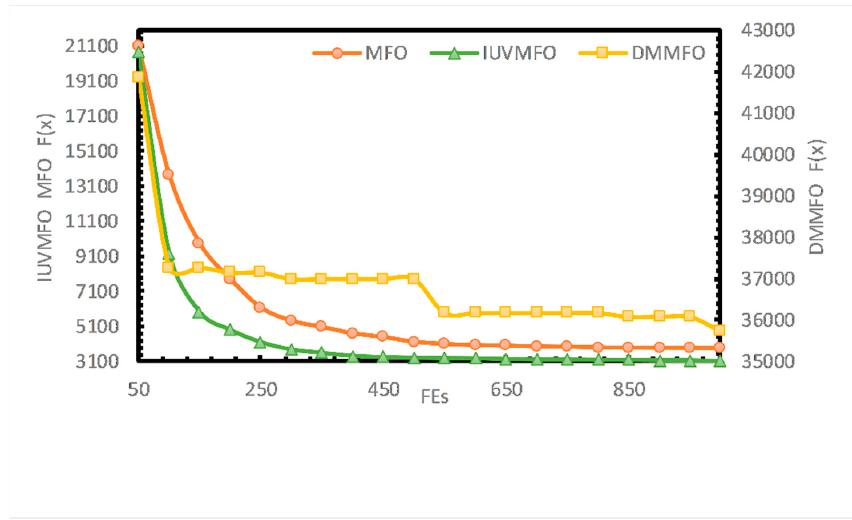
Figure 10. The result curve of F25. Table 9. Statistics of 50-dimensional Function Test Results.